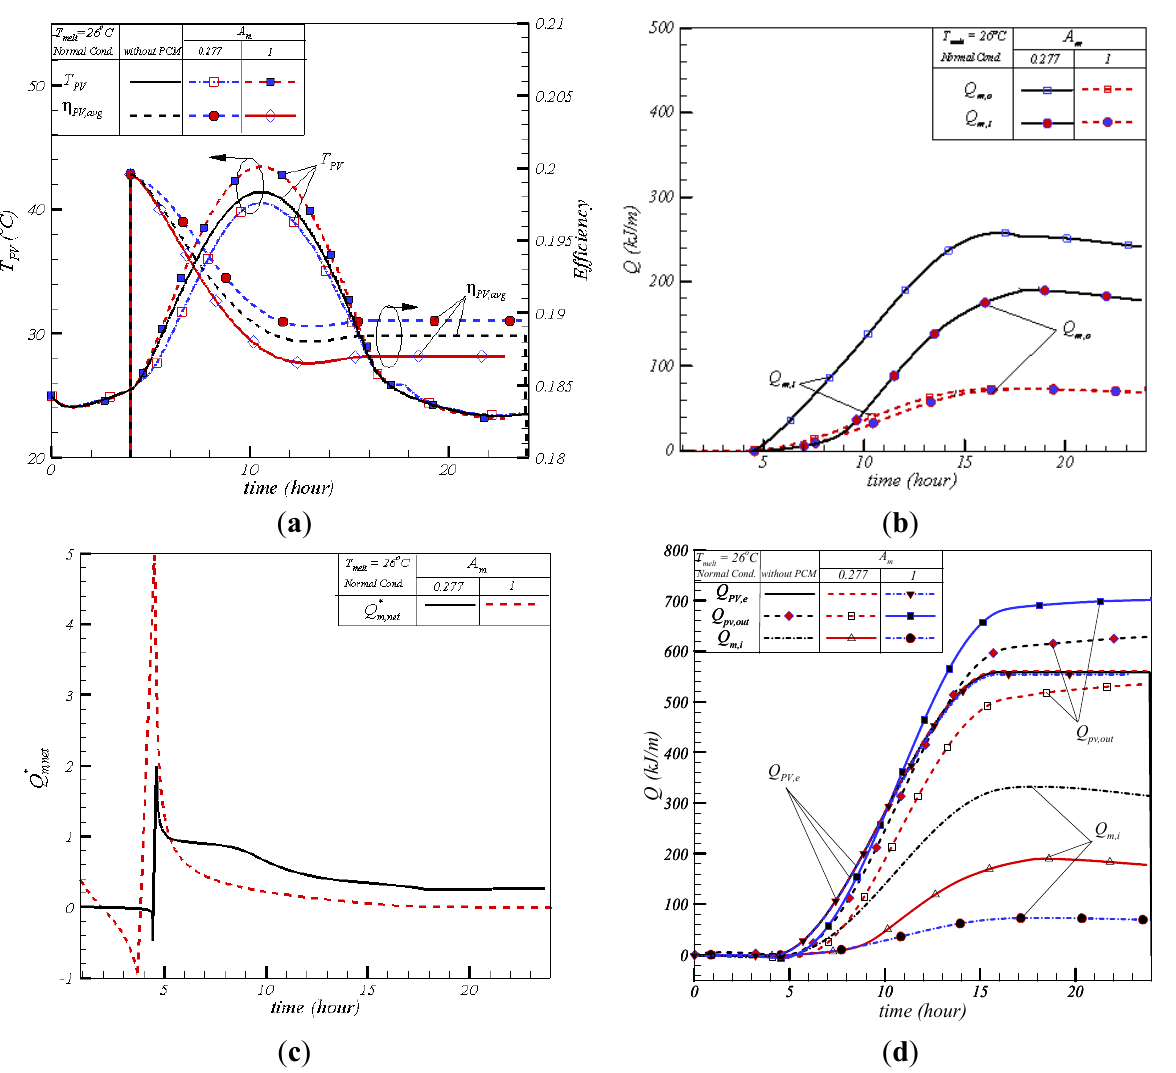
Figure 3. Thermal and electrical performance of PV module with and without MEPCM = 0.277 and 1. ( a ) Average temperature and efficiency layer of different aspect ratios of A m of PV cell; ( b ) Total heat transfer rate across the MEPCM layer; ( c ) Fraction of energy stored inside the MEPCM layer; and ( d ) Total heat transfer rate across the PV